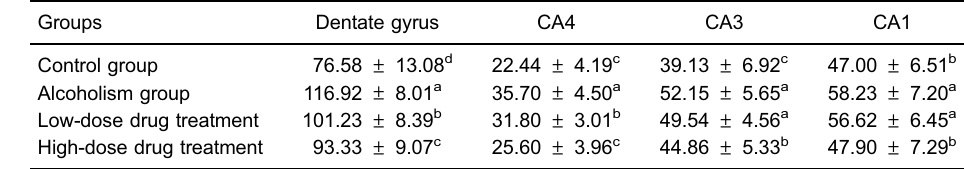
Table 3. Number of p75 neurotrophin receptor (p75NTR)-positive neurons in the dentate gyrus and hippocampus (CA4, CA3, and CA1) in the four groups.